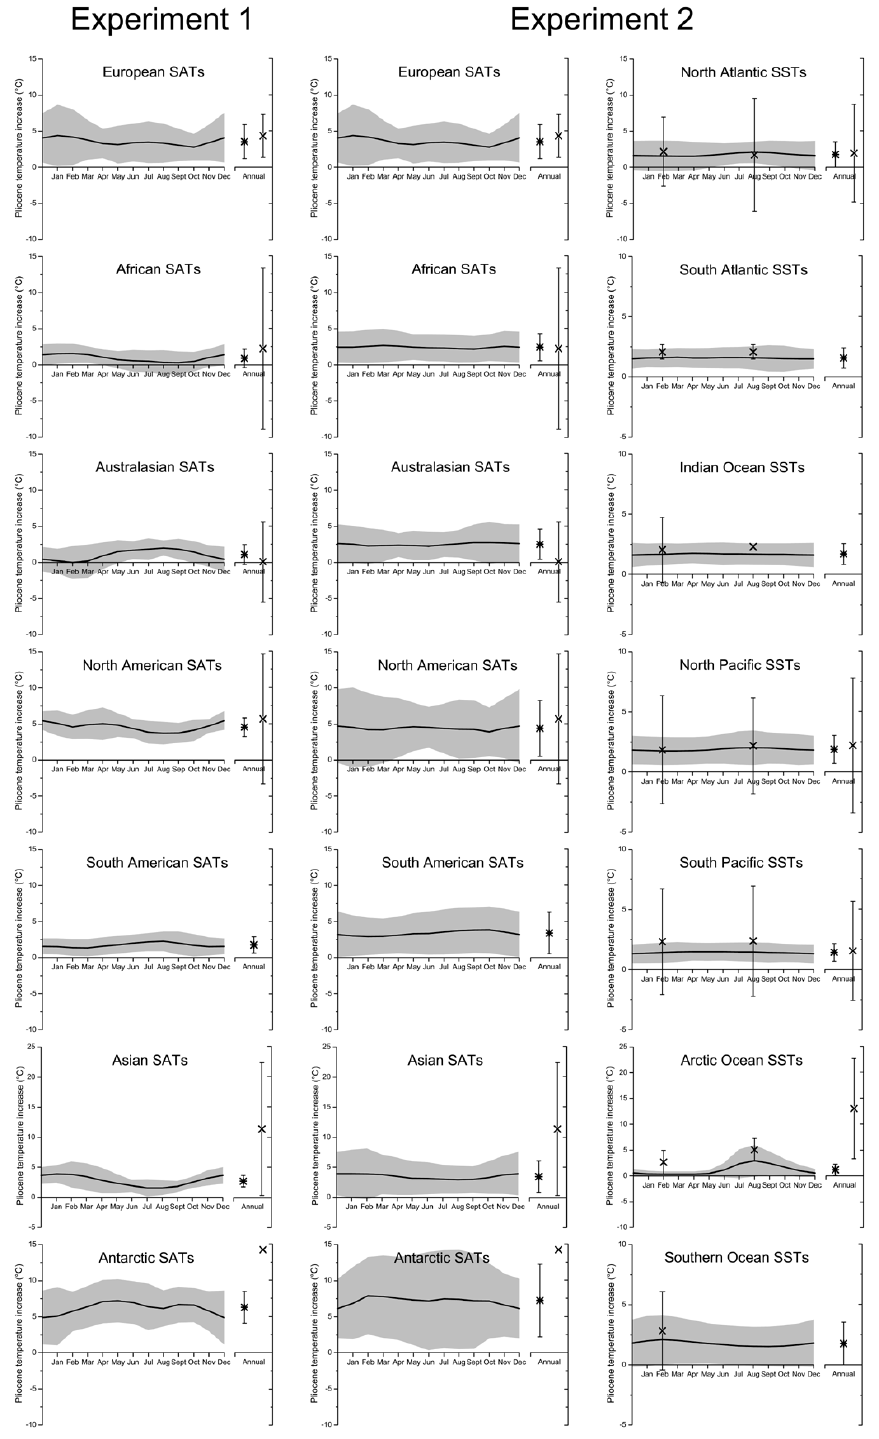
Fig. 6. Regional marine and terrestrial annual and monthly mean data/model comparisons. Comparison includes the calculated model 2 σ derived from Experiment 1 and 2 models regional averages. Left column: Experiment 1 terrestrial regions. Middle column: Experiment 2 terrestrial regions. Right column: Experiment 2 marine realm. Error bars on the data (crosses) are derived from spatial variability over the region (i.e. does not represent variability or uncertainty). In the annual means the stars represent the modelled annual mean and the crosses the proxy data. Terrestrial data comes from palynological and biome estimates (Salzmann et al., 2013). February and August SST estimates are derived from assemblage data, while annual mean SST data are Mg/Ca and alkenones estimates (Dowsett et al., 2010,